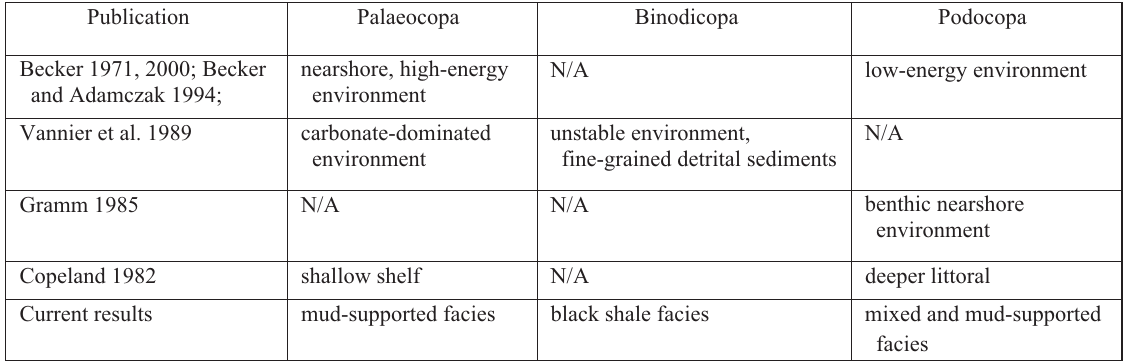
N/A (cid:177) not